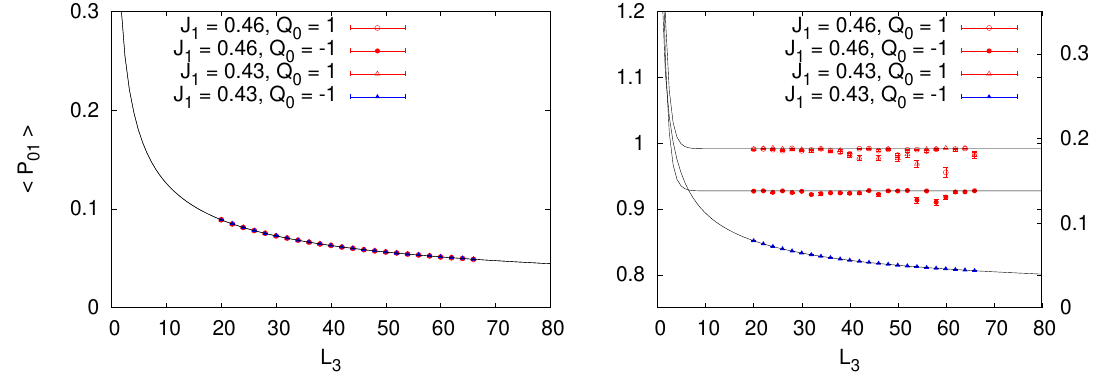
1 dependence of the h P plane on the length L 2 01 i 3 = 0 . 10 and different J = 0 . 43 and J = 0 . 46 for both topological 2 1 1 plane on the transverse direction L 01 i = 0 . 43 and J = 0 . 46 for both values of the topological charge. The 1 1